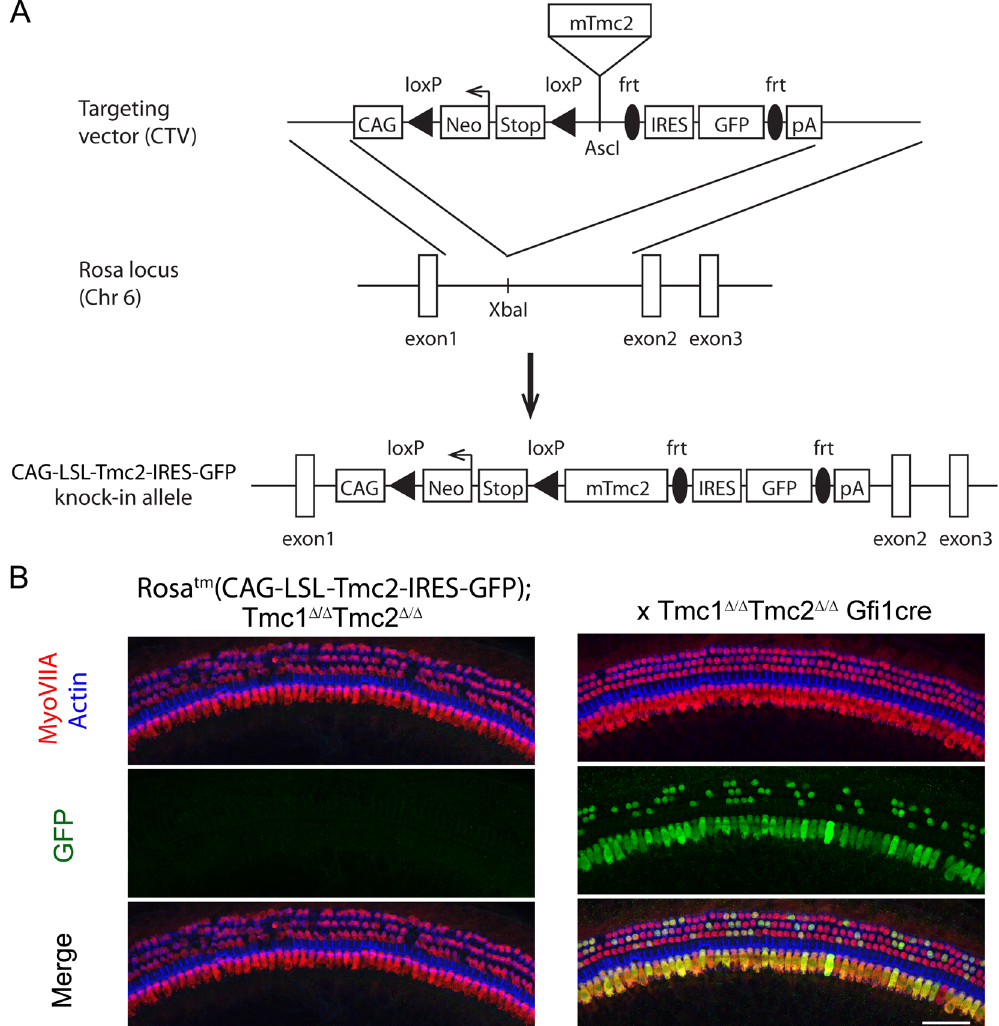
Figure 1. Generation of Rosa26 tm ( CAG-LSL-Tmc2-IRES-GFP ) mouse model. ( A ) Mouse Tmc2 cDNA was inserted into the CAG-STOP-GFP-Rosa targeting vector, CTV, between a floxed Stop cassette and the internal ribosome entry site (IRES) followed by the enhanced Green Fluorescent Protein gene (eGFP). Transcription is under control of the CAG promoter. The targeting vector contained Rosa26 homology arms (1 kb 5 ′ and 3.8 kb 3 ′ ), so that the entire loxP-stop-loxP-Tmc2-IRES-GFP transcriptional cassette was inserted into the first intron of Rosa26 gene on chromosome 6. ( B ) When expressed with Gfi1 Cre , excision of the stop codon lead to expression of Tm [ Tmc2 ] and GFP in IHCs and OHCs. GFP expression was evident at P16. Hair cells were labeled with rabbit anti-MYOVIIa (red), GFP signal is amplified with a goat anti-GFP antibody (green) and phalloidin counterstain labeled actin filaments (blue). Scale bar 50 μ